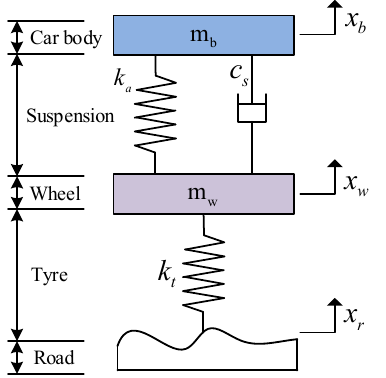
Figure 11. Model of quarter car passive suspension.